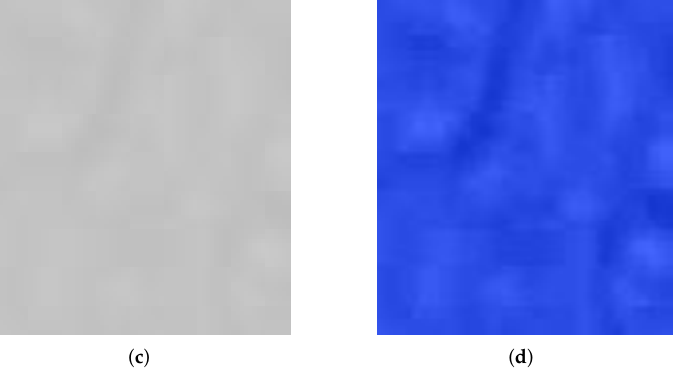
Figure 7. GradCAM visualization of trained ResNet18’s last layer response to different types of input. Shown are ( a ) an input patch containing three unusually shaped bacteria with clogged stomata and ( b ) the corresponding bottleneck layer activations, which show the highest responses around the most salient content; ( c ) a background patch and ( d ) the corresponding bottleneck layer activations, which are nearly non-existent. As expected, the patch in ( a ) results in the regression prediction for the bacterial count of 2.847, and the patch in ( c ) for a count of